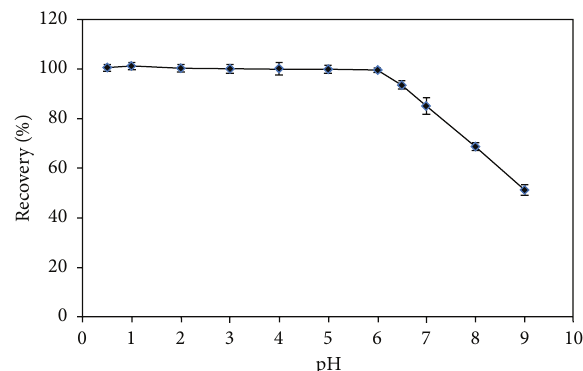
Figure 1: Effect of pH on the recovery of silver. Conditions: amount of silver 10 𝜇 g; sample volume 50 mL; sample flow rate 5.0mLmin −1 ; solvent for dissolving adsorbent DMF (5.0 mL).